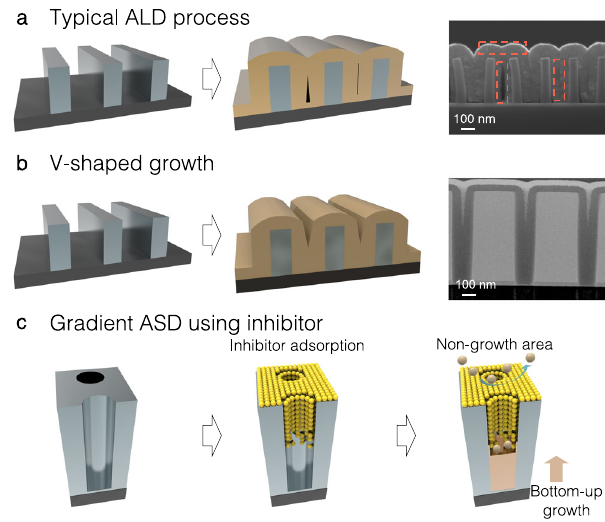
Fig. 1 | Schematic illustrations of ASD processes for seamless gap- fi